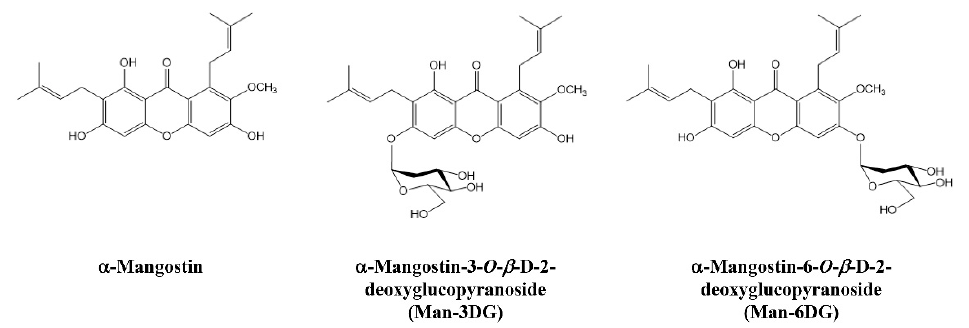
Figure 1. The chemical structures of α -mangostin and α -mangostin glycosides.